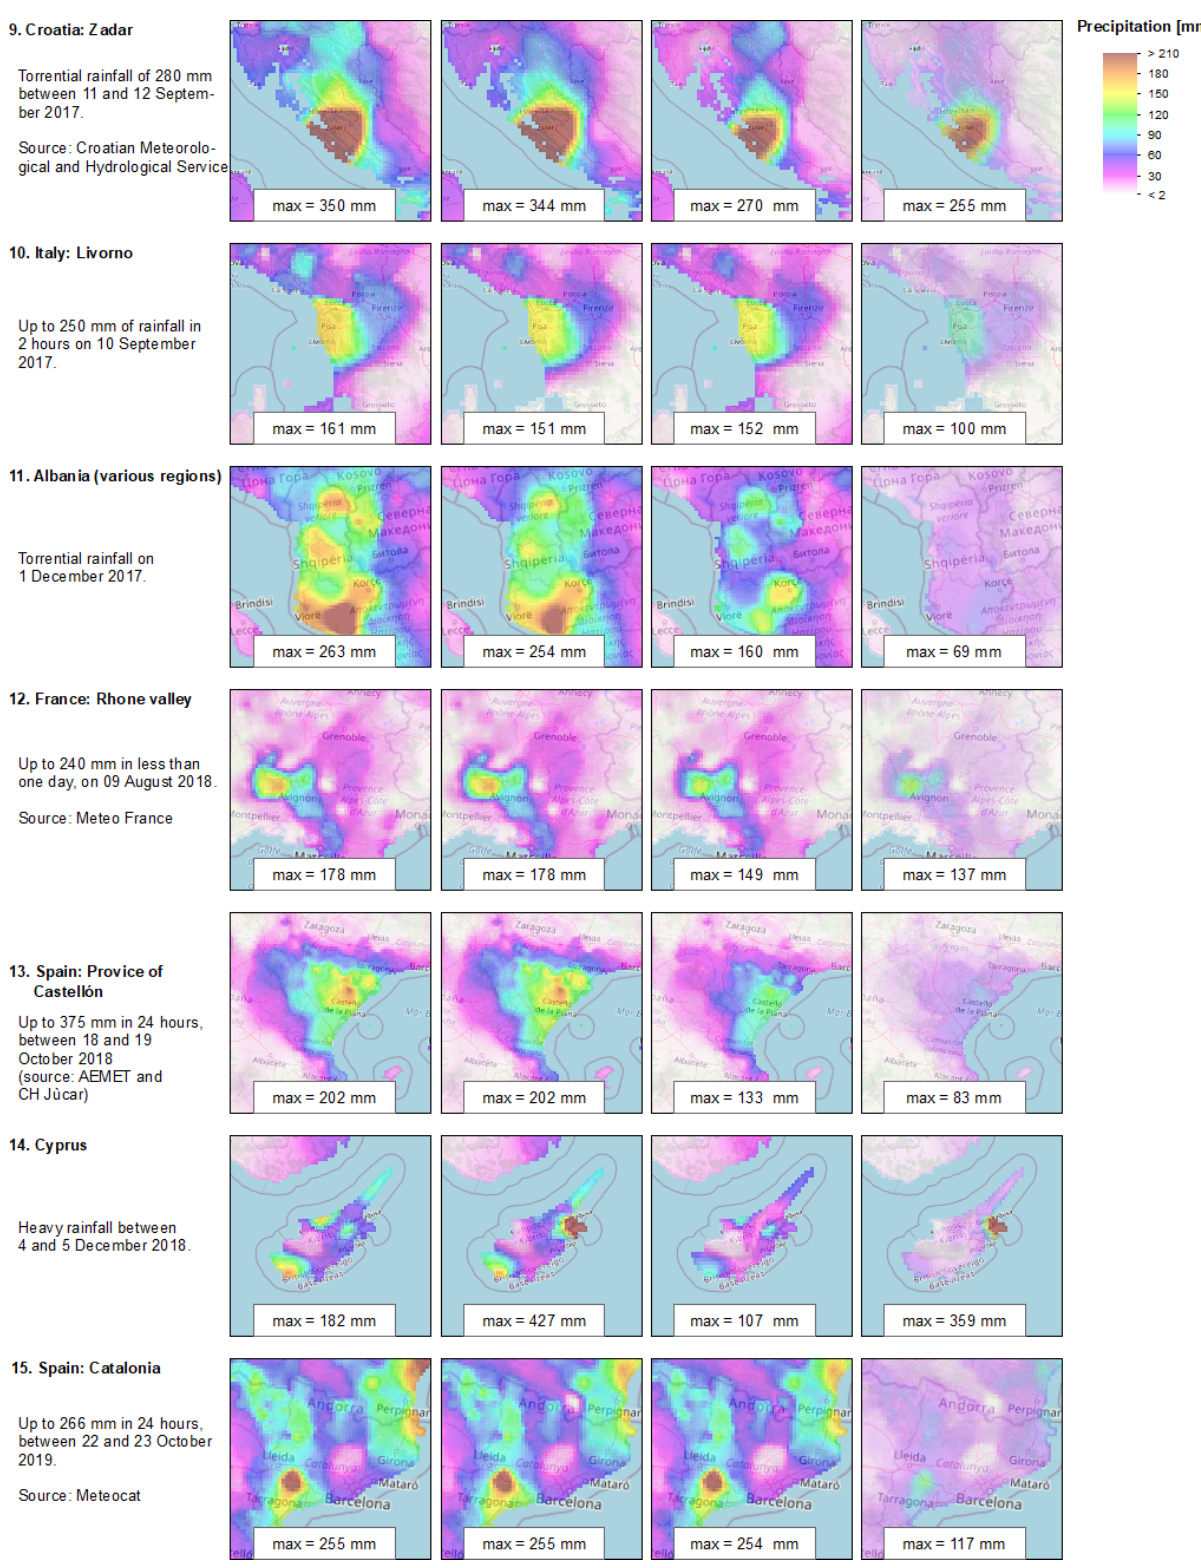
Figure 12. Semi-qualitative evaluation of 15 high-intensity precipitation events through comparing information reported on FloodList (on the left) with the footage of the 6-hourly and daily precipitation grids (sums and maximum; base map from © OpenStreetMap contributors 2020. Distributed under the Open Data Commons Open Database License (ODbL)